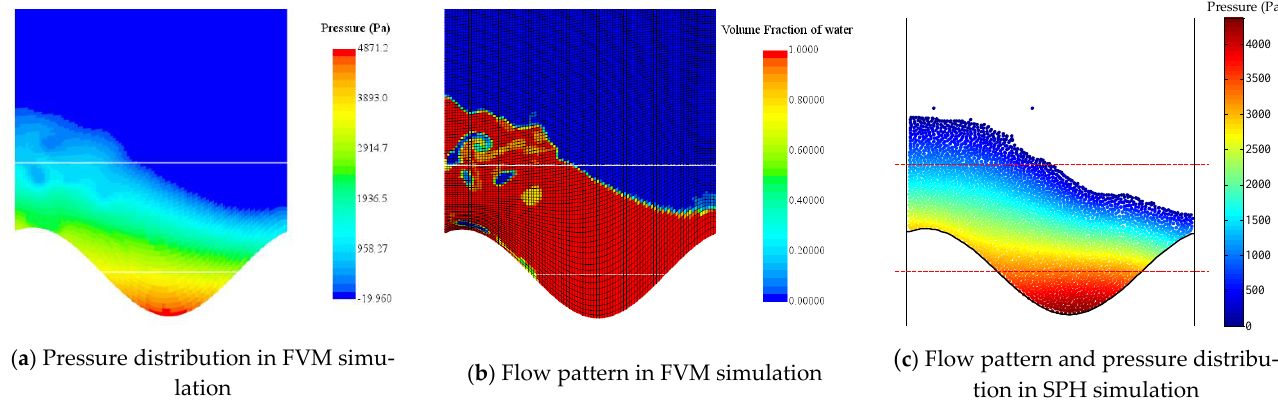
Figure 17. Comparisons of the flow pattern and pressure distribution at 7.8 s: ( a ) Pressure distribution in FVM simulation; ( b ) Flow pattern in FVM simulation; ( c ) Flow pattern and pressure distribution in SPH simulation.